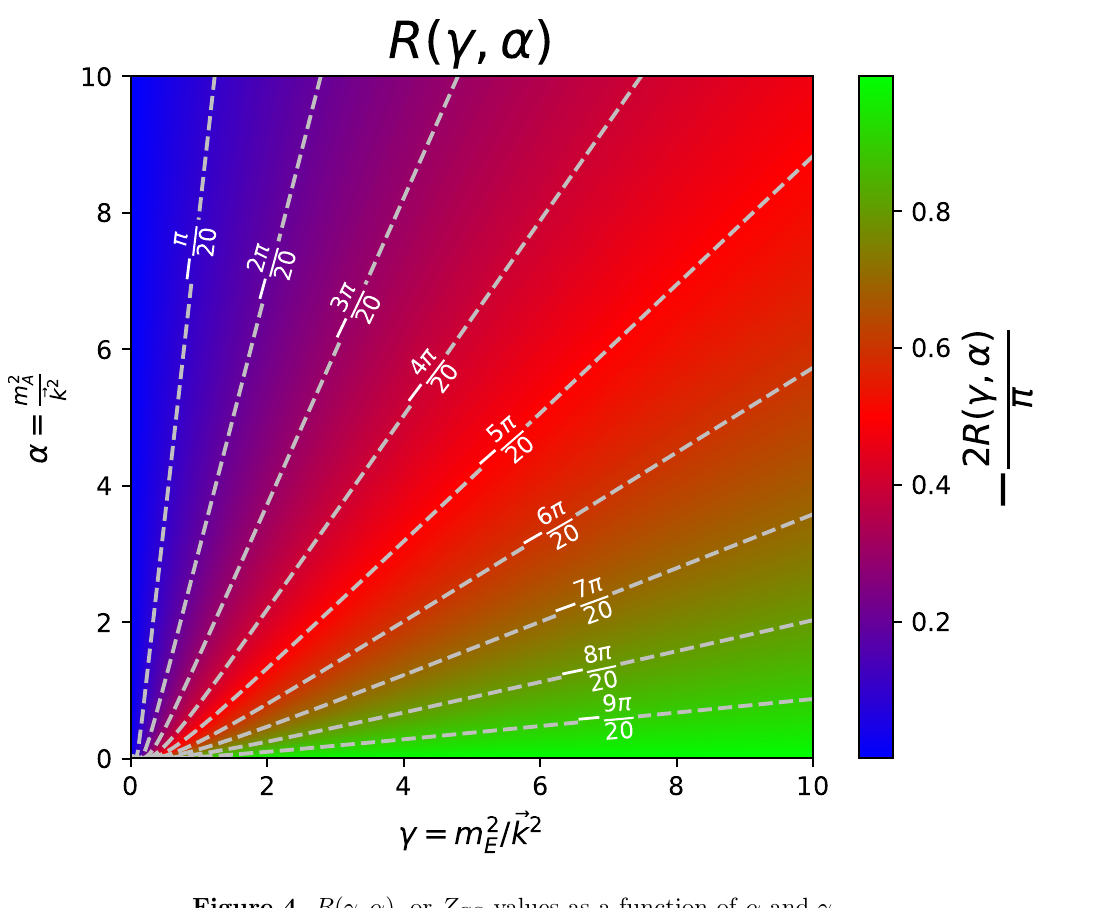
Figure 4 . R ( (cid:13); (cid:11) ), or Z GS values as a function of (cid:11) and (cid:13)